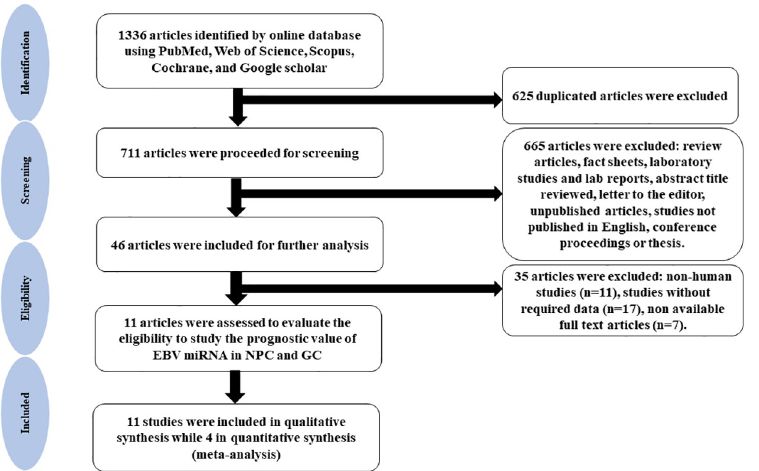
Fig 1. Flow chart of the study selection